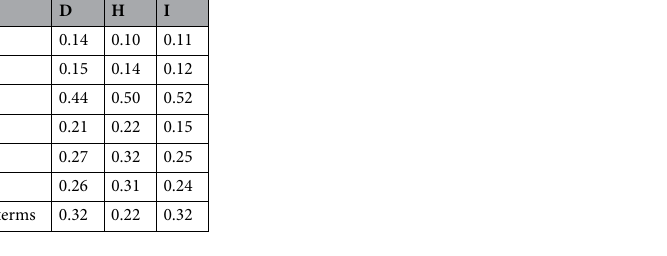
Table 4. ACM dataset.